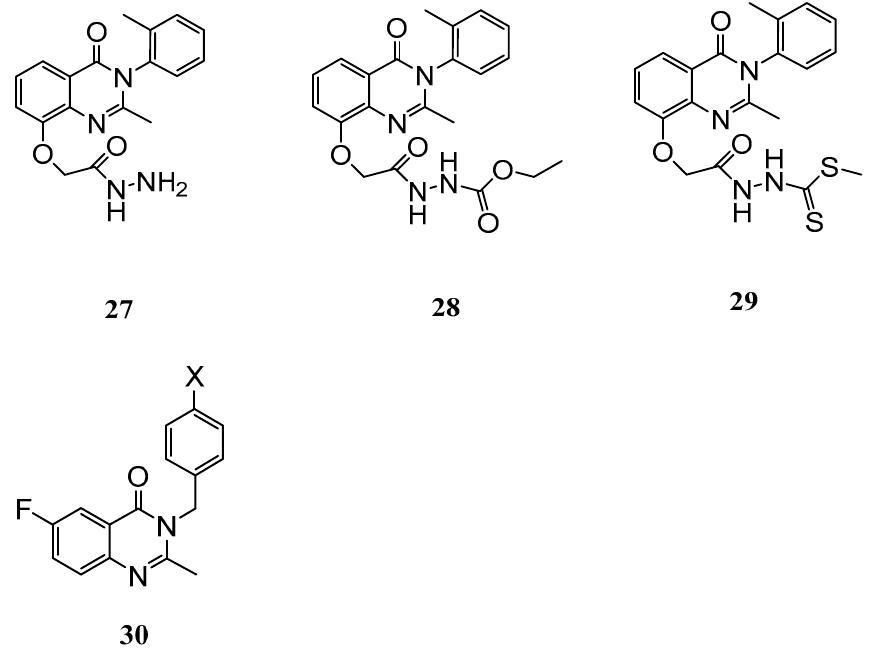
Figure 4 . Docking of one of the active compounds in the active site of human carbon anhydrase II (left) and the electrostatic surface potential of human carbon anhydrase II in complex with the active compound [32]. New derivatives of ((E)-3-(5-((sub-phenylamino) methyl)-1,3,4-thiadiazol-2-yl)- 2styrylquinazolin-4(3 H )-one are chemically prepared and evaluated for their anticonvul- sant property. Eight synthesized chemicals have shown excellent anticonvulsant efficacy and protection against MES convulsion. These drugs can be expected to have better activ- ity than phenytoin and carbamazepine but failed to show the effect after 4 h of admin- istration [33]. 3.4.2. Anti-Alzheimer’s Activity Haghighijoo et al. (2017) investigated a β -site Amyloid precursor protein Cleaving Enzyme 1 (BACE1) and explained the importance of this protein as a significant target for the treatment of Alzheimer’s disease. Non-peptide inhibitors (quinazolinone-based hy- drazones) of BACE1 were investigated using different enzymatic assays. Compound 37 was found to possess the highest activity to prevent the formation of β -amyloid which consequently protects the brain cells against apoptosis that help in delaying the appear- ance of Alzheimer’s disease. Molecular docking studies (Figure 5) confirmed a strong in- teraction between compound 37 and the key residues of the BACE1 active site [34].